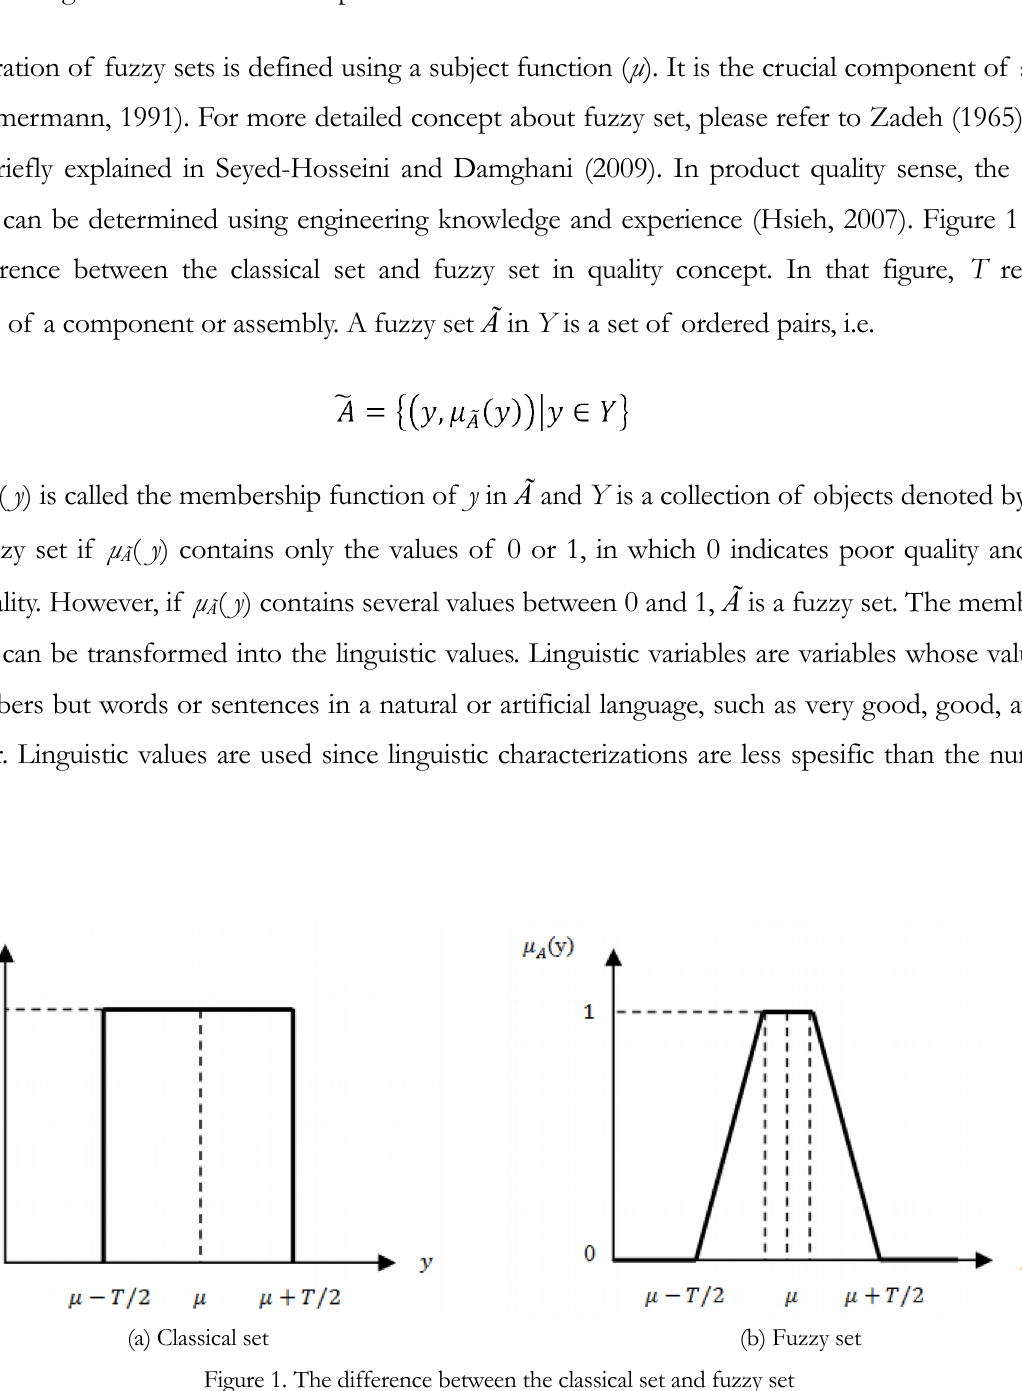
Figure 1. The difference between the classical set and fuzzy